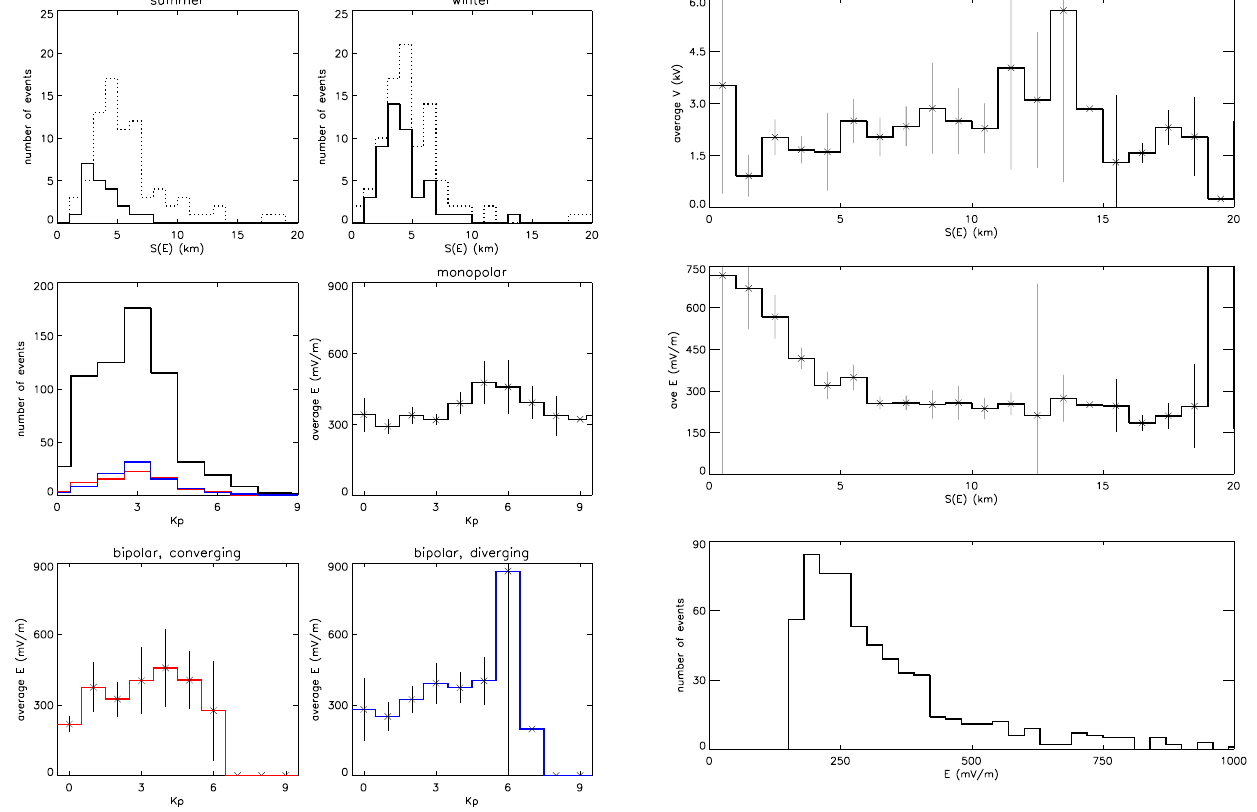
Fig. 5. Upper panels: Number of events vs. S(E) for high ( K p > 3, solid line) and low ( K p ≤ 3, dotted line) geomagnetic activity and summer (left) and winter (right). Each season is defined as a three month period. Middle and lower panels: Number of events vs. K p and average electric field magnitude for bins in K p , events sepa- rated for monopolar (black line) and diverging (blue line) and con- verging (red line) bipolar electric fields. The error bars indicate the 95.5% confidence interval. If no error bar is indicated, then this bin contains no or only one event.